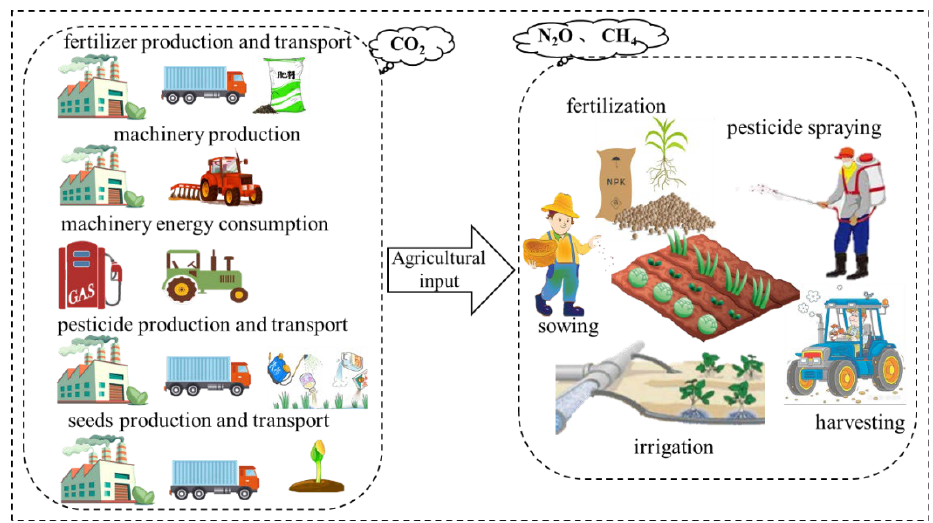
Figure 1. The system boundary of major crop production in